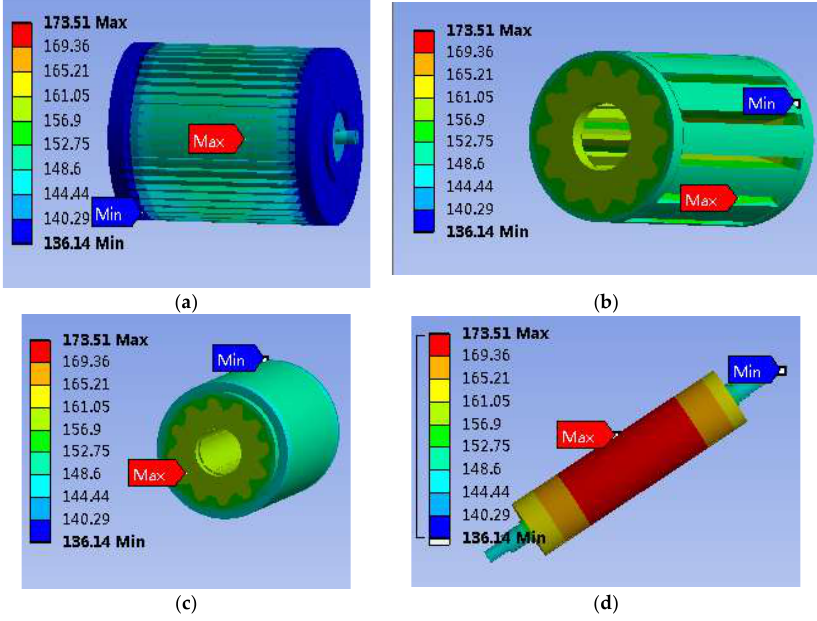
Figure 9. Temperature distribution of the optimal motor, ( a ) Temperature distributon of motor; ( b ) Temperature distributon of motor winding; ( c ) Temperature distributon of stator; ( d ) Temperature distributon of